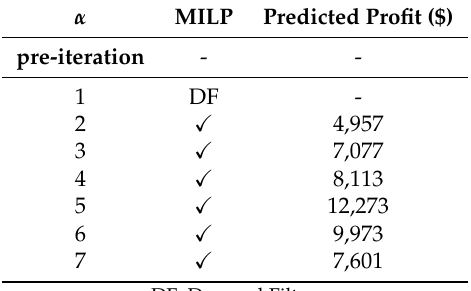
Table 18. Alpha Iterations: Additional scenario.